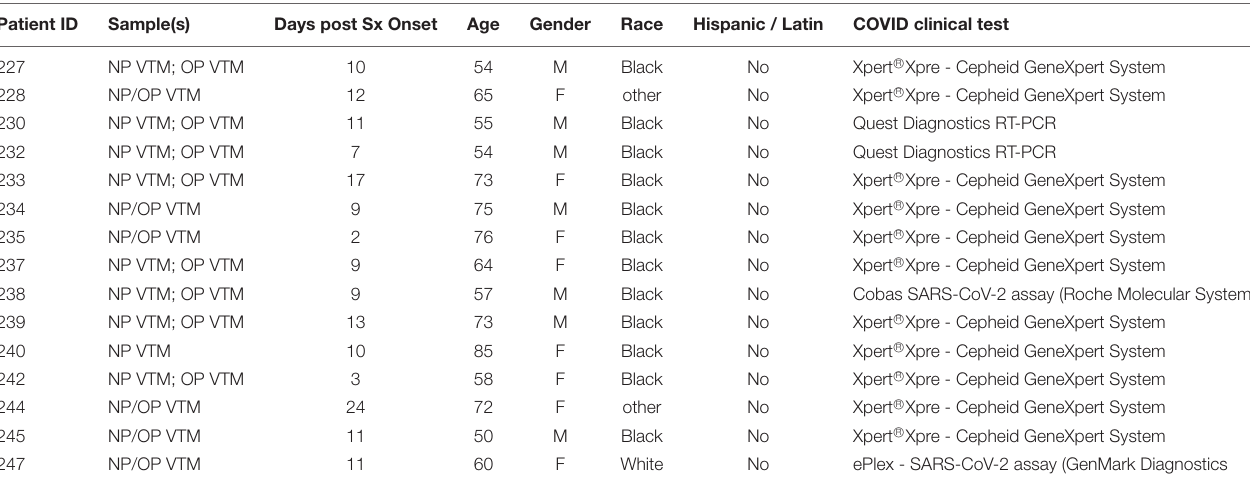
TABLE 2 | Patient